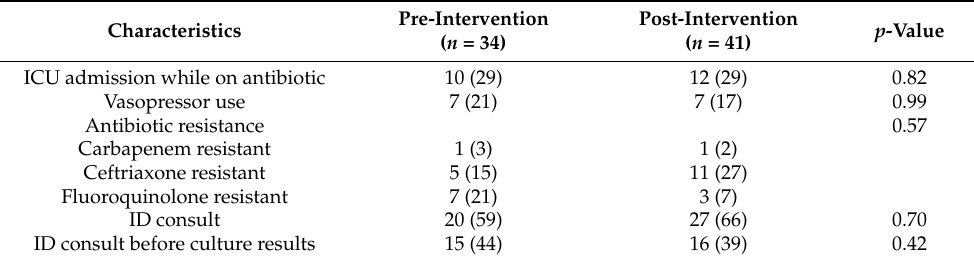
Table 3. Subgroup analysis of patients who did not achieve primary